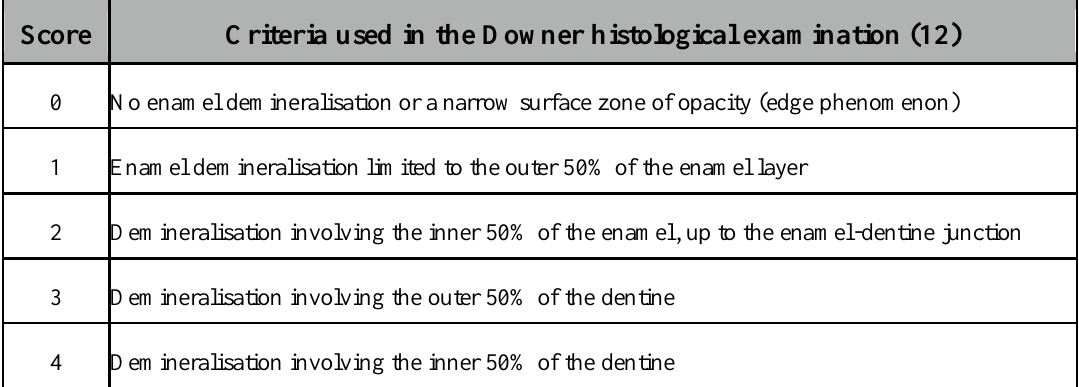
Table 2. Criteria used in the histological examination